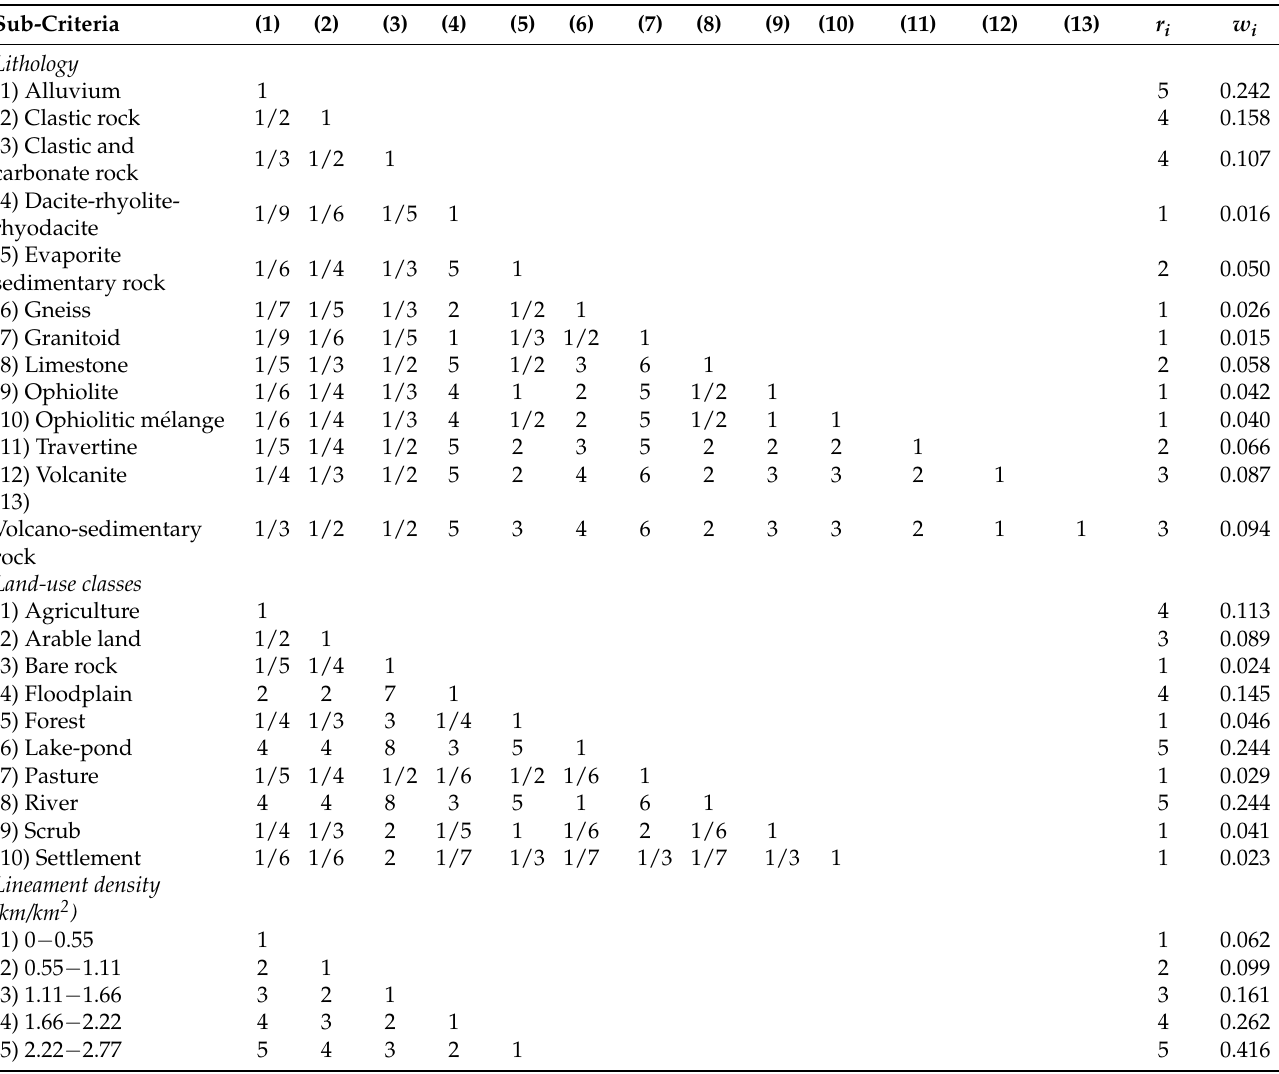
Table 5. The pairwise comparison matrix and normalised weight ( w i ) of the sub-criteria with standardised ratings ( r i ).